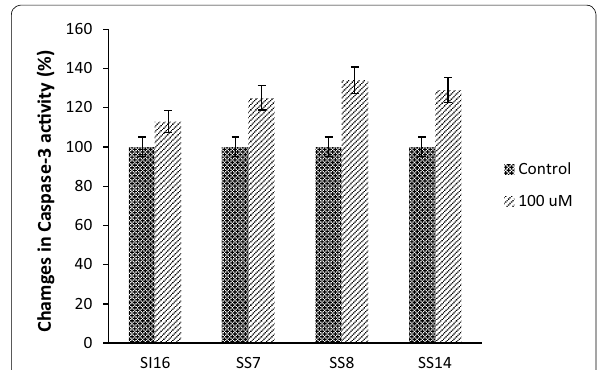
Fig. 1 Caspase3 activity in MCF7 cells after 48 h. The results are the means of two independent experiments. P < 0.05 was considered